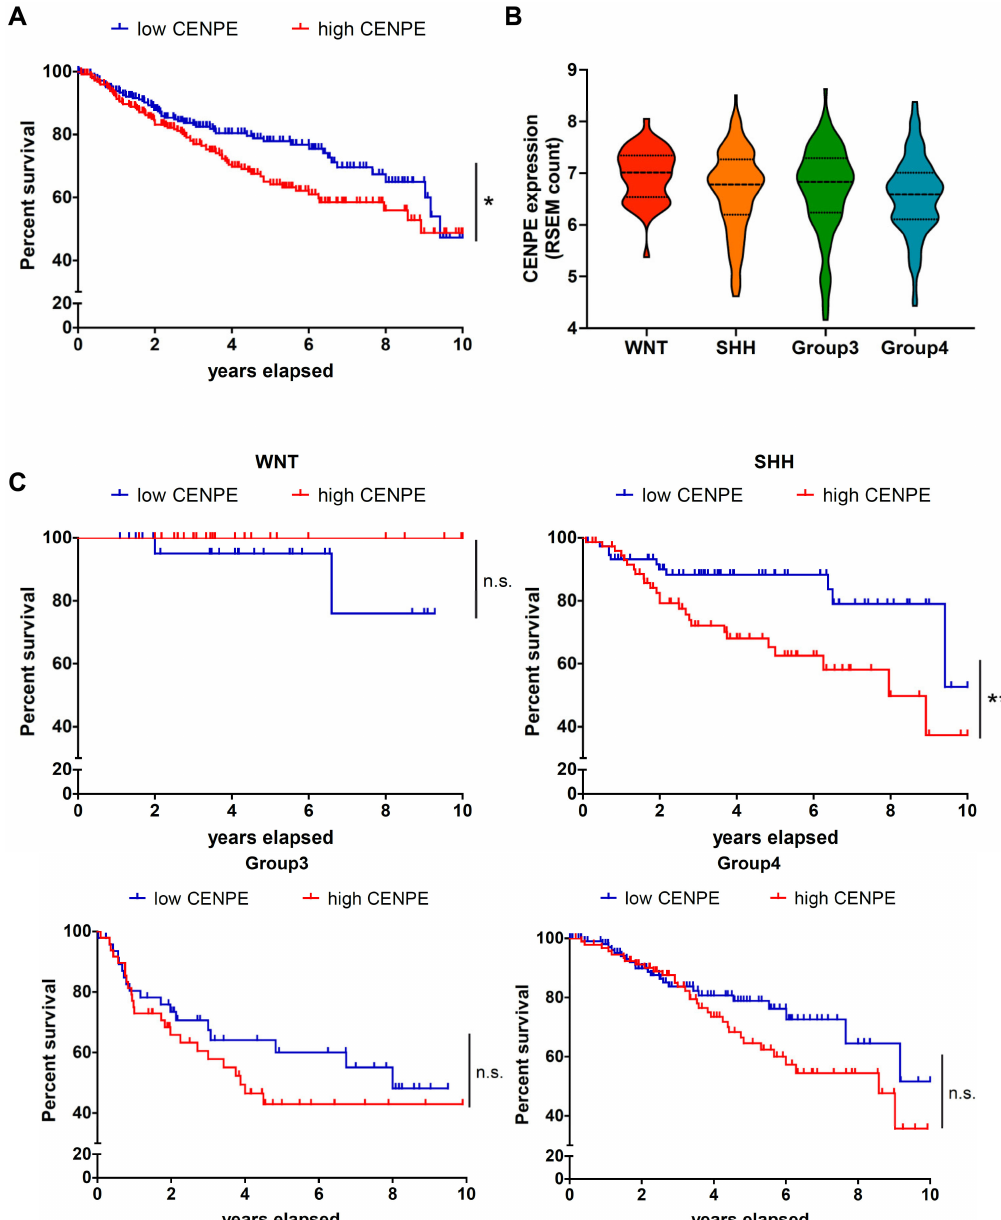
Figure 1. The expression of CENPE correlates with MB patients’ prognosis. ( A ) Kaplan-Meier survival curves of MB patients. The two groups were defined on the basis of CENPE expression high (red) or low (blue) based on median value. p -value = 0.0318, Log-rank test statistics ( B ) Graph showing expression level by RSEM count of CENPE divided by molecular subgroups ( C ) Kaplan-Meier survival curves of MB patients divide by molecular subgroups and finally subdivided in two groups on the basis of CENPE expression high (red) or low (blue) based on median value. WNT p -value = 0.1385 SHH p -value = 0.0091 Group3 p -value = 0.2815 Group4 p -value = 0.1363, Log-rank test statistics. *, p < 0.05; **, p < 0.01; n.s., not